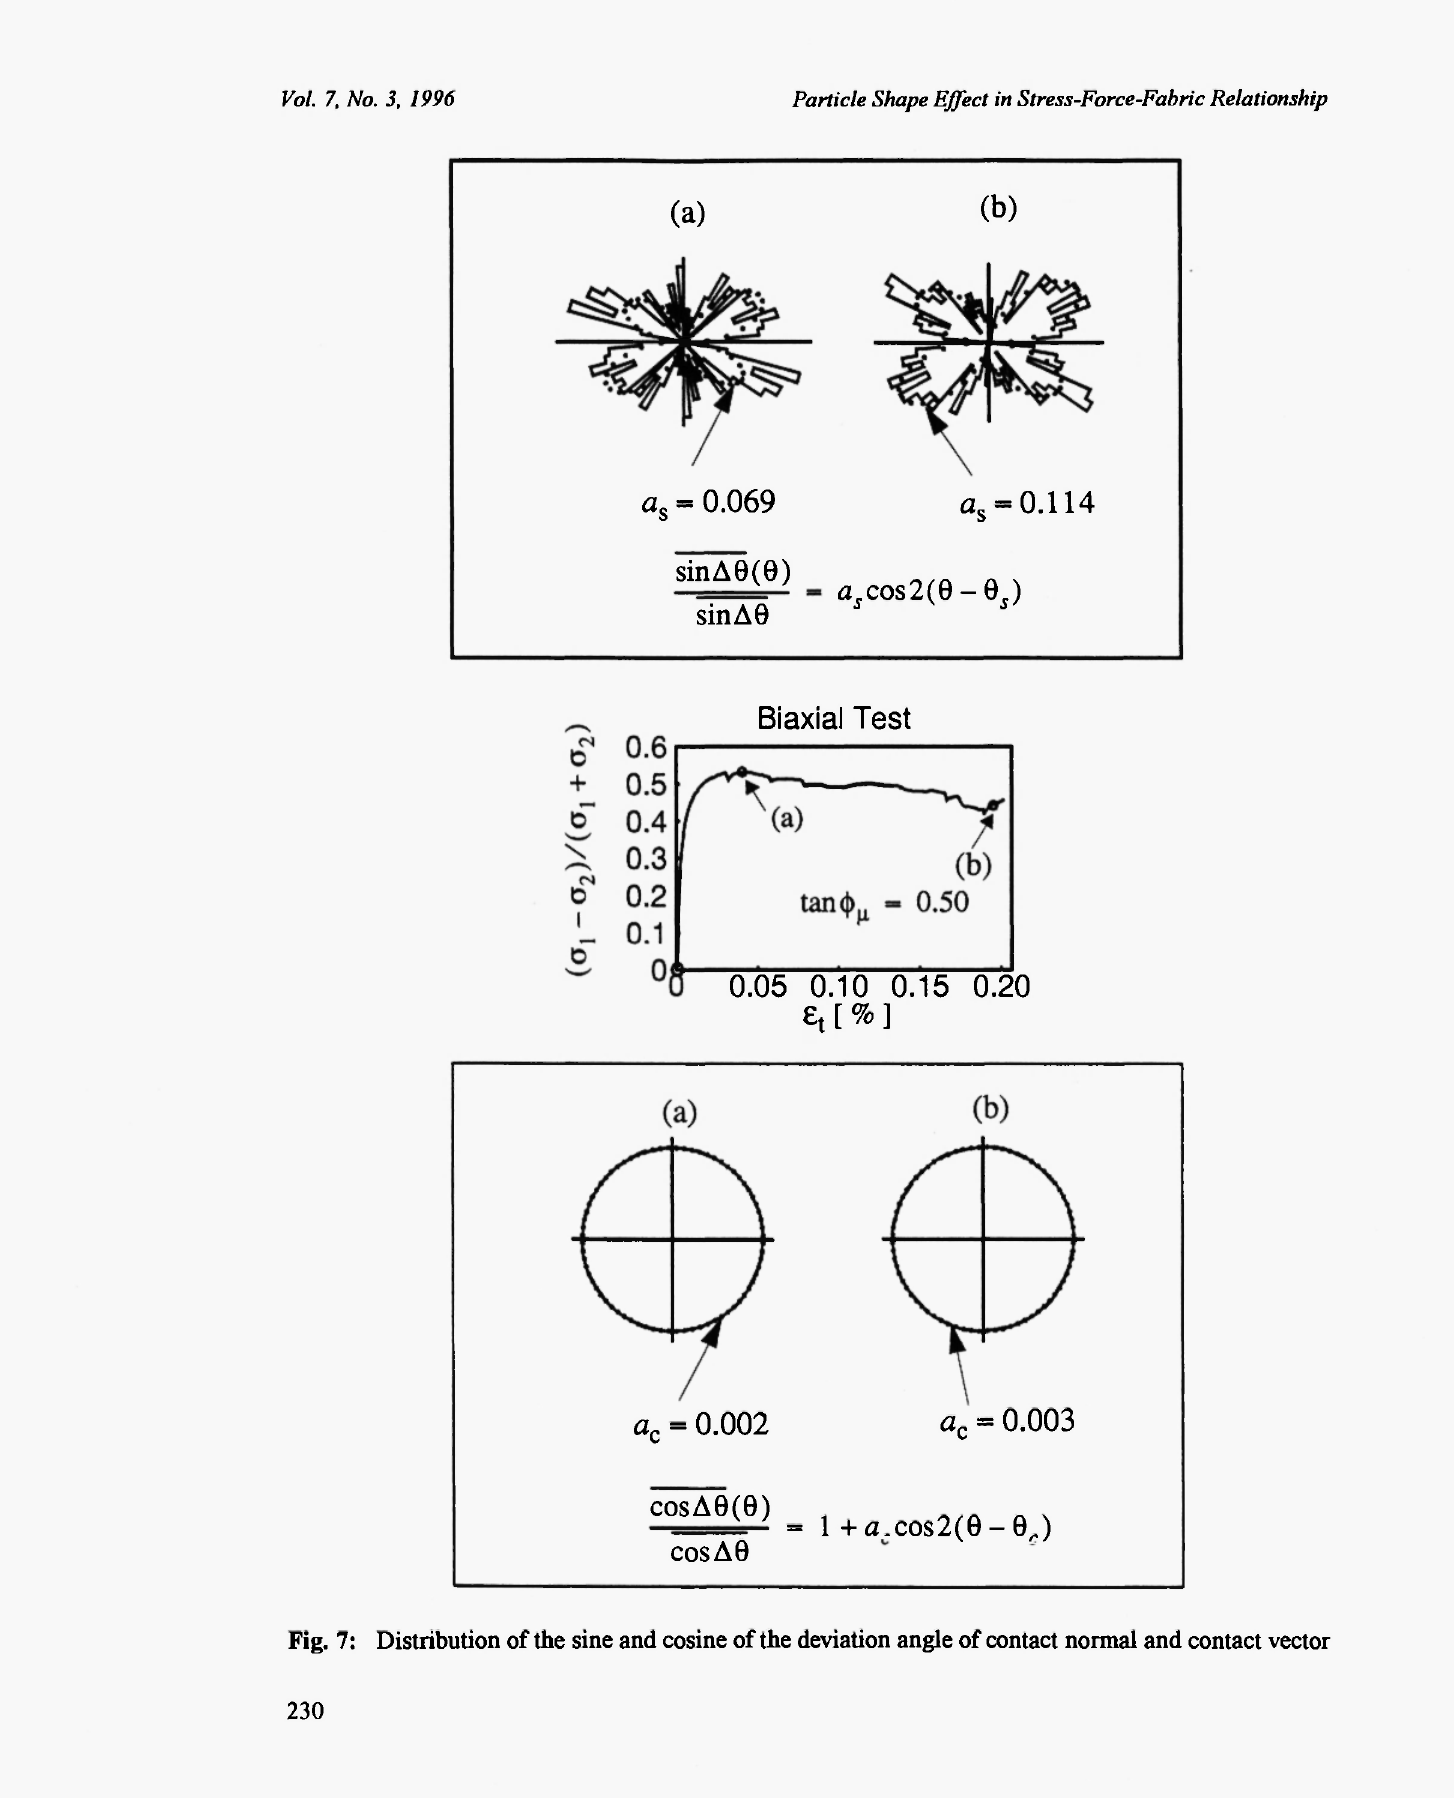
Fig. 7: Distribution of the sine and cosine of the deviation angle of contact normal and contact vector